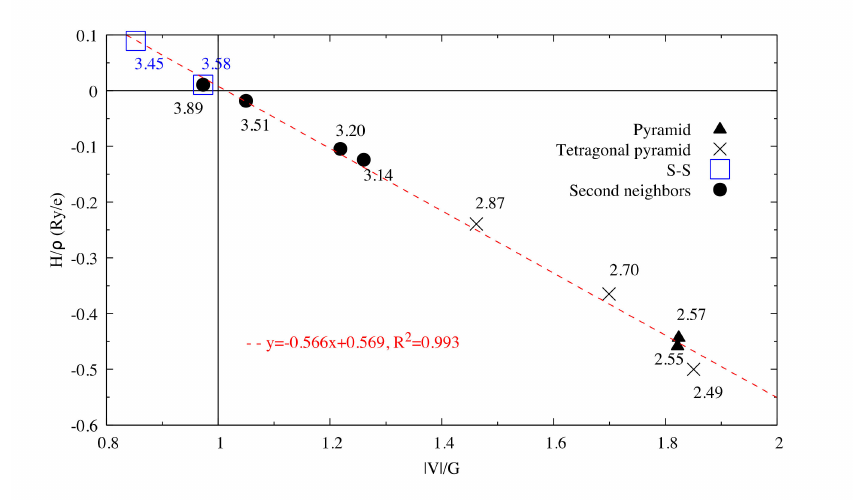
Figure 2. H b / ρ b vs. | V b | G b for interactions in Sb 2 S 3 . The dash line corresponds to the fitting line for Sb–S interactions by least square method. The numbers related to the di ff erent points correspond to the bond length (in